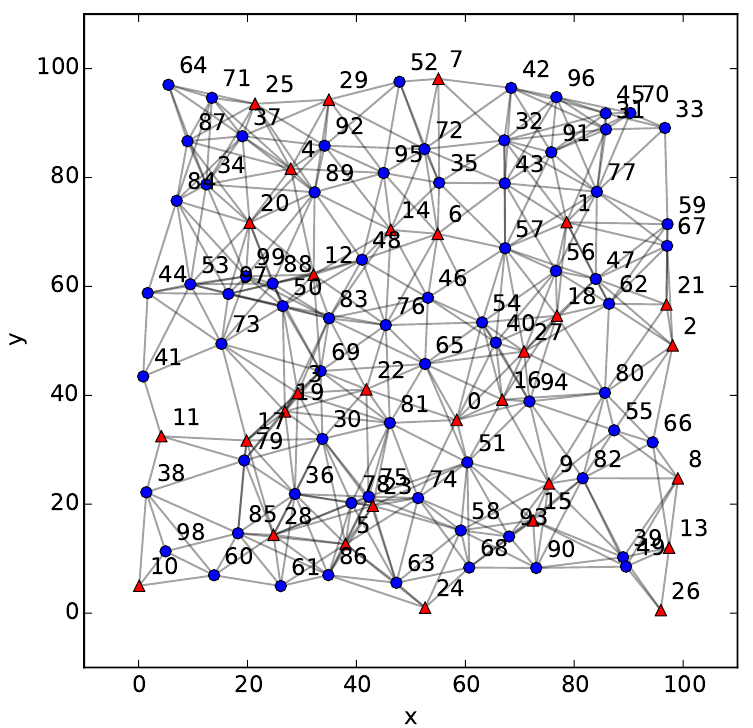
Figure 9. The configuration of the WSN used with the DV-Hop